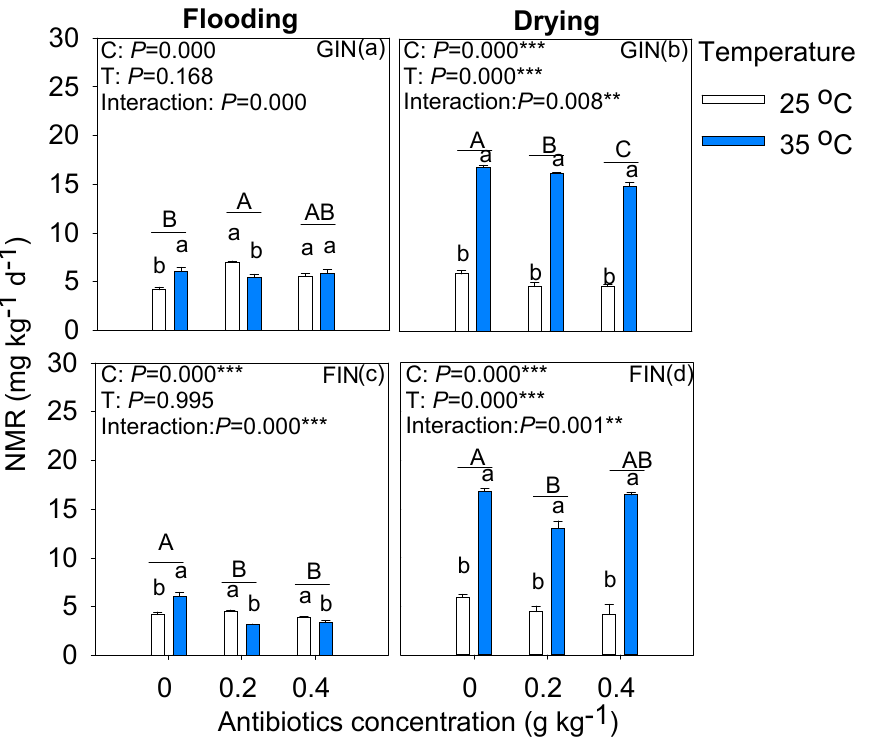
Figure 5. Net N-mineralization (NMR) with the antibiotics content of 0, 0.2 and 0.4 g kg − 1 in the flooding and drying conditions at 25 °C and 35 °C. Different uppercase letters indicate significant differences among antibiotics concentrations of 0, 0.2 and 0.4 g kg − 1 ; Different lowercase letters represent significant differences between 25 °C and 35 °C at the same antibiotic concentration ( p < 0.05). Different numbers of asterisks represent a significant difference (* p < 0.05, ** p < 0.01, *** p < 0.001).